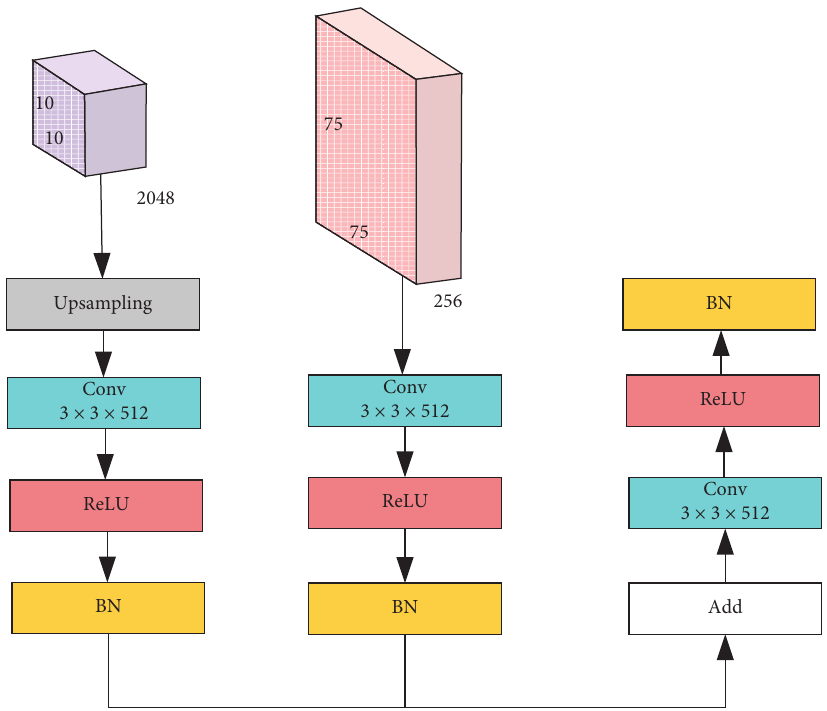
Figure 5: Features of cross-level fusion